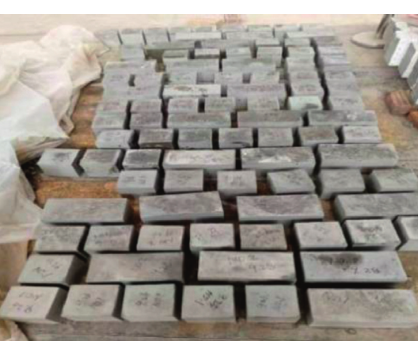
Figure 2: RCASCC.